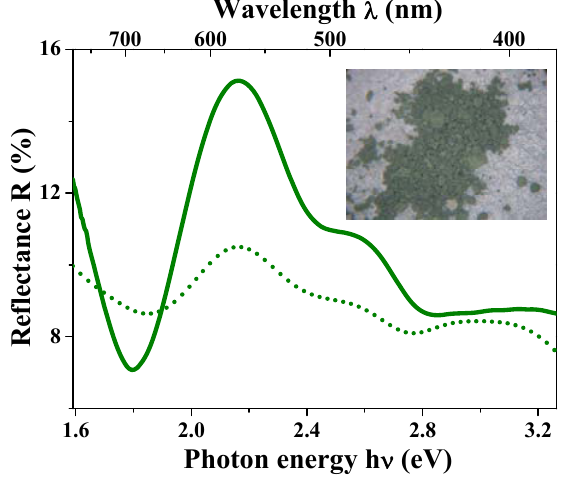
O hollow spheres. The green solid and 3 4 O hollow 3 4